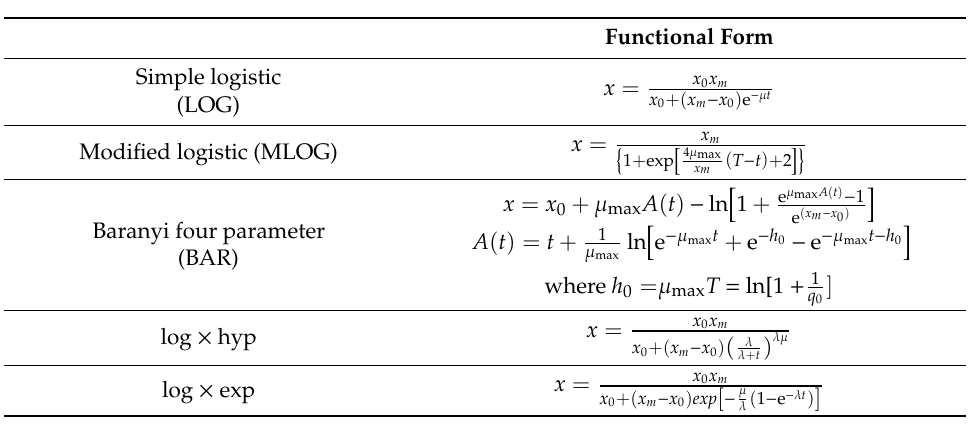
Table 1. Evaluated growth